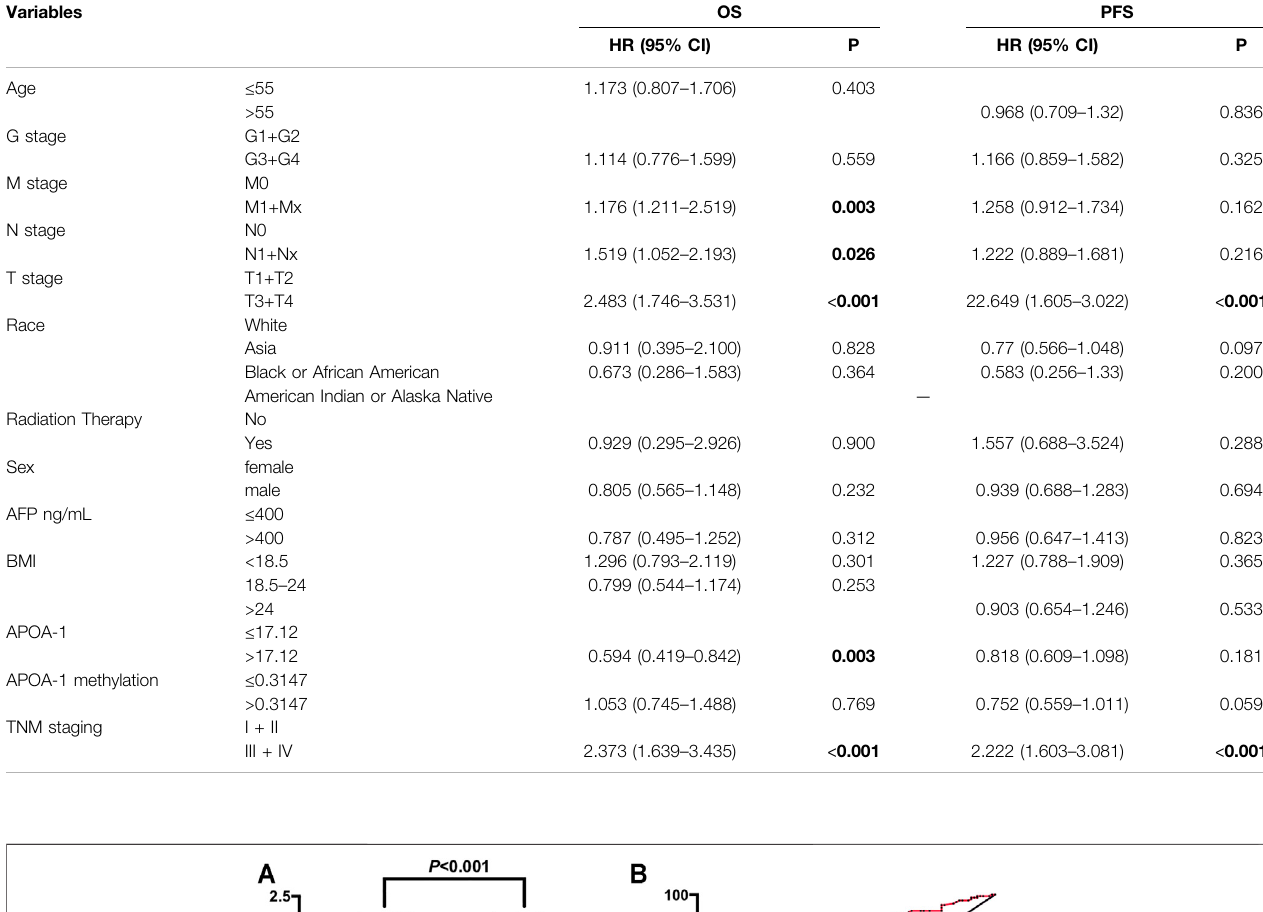
TABLE 1 | Multivariate Cox regression analyses of independent prognostic factors for overall survival and Progression-free survival in patients with HCC from TCGA cohort.